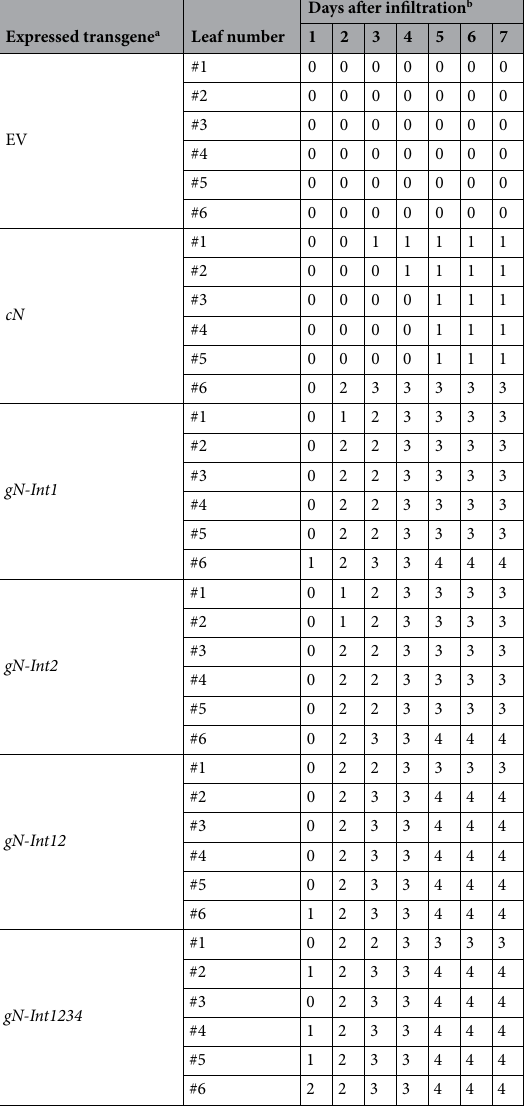
tor. The difference in transcript levels between gN-Int1 and gN-Int2 (Figs. 3 and 4) did not affect the speed of appearance and phenotype of cell death. Cooperative roles of introns 1 and 2 in N -mediated virus resistance in Nicotiana benthami- ana . To further investigate roles of introns 1 and 2 in virus resistance, we carried out an agrobacterium-medi- ated inoculation experiment using cN , gN-Int1234 , gN-Int1 , gN-Int2 , and gN-Int12 , and an infectious ToMV mutant clone encoding ER-targeting GFP instead of coat protein (ToMV-erGFP) 15 . Nicotiana benthamiana was used because it has been shown to induce N -mediated virus resistance without visible cell death 15,37 . Changes in the size of infection foci indicated by GFP fluorescence were monitored under a fluorescent microscope. We firstly determined percentages of a total fluorescent area, representing accumulation of ToMV-erGFP, over a co-infiltrated area with cN or gN-Int1234 from 4 to 6 dpi. Fluorescent areas for leaf tissue infiltrated with gN-Int1234 were significantly smaller than those infiltrated with cN during the observation period, indicating that virus resistance mediated by gN-Int1234 was stronger than that mediated by cN . On the other hand, the